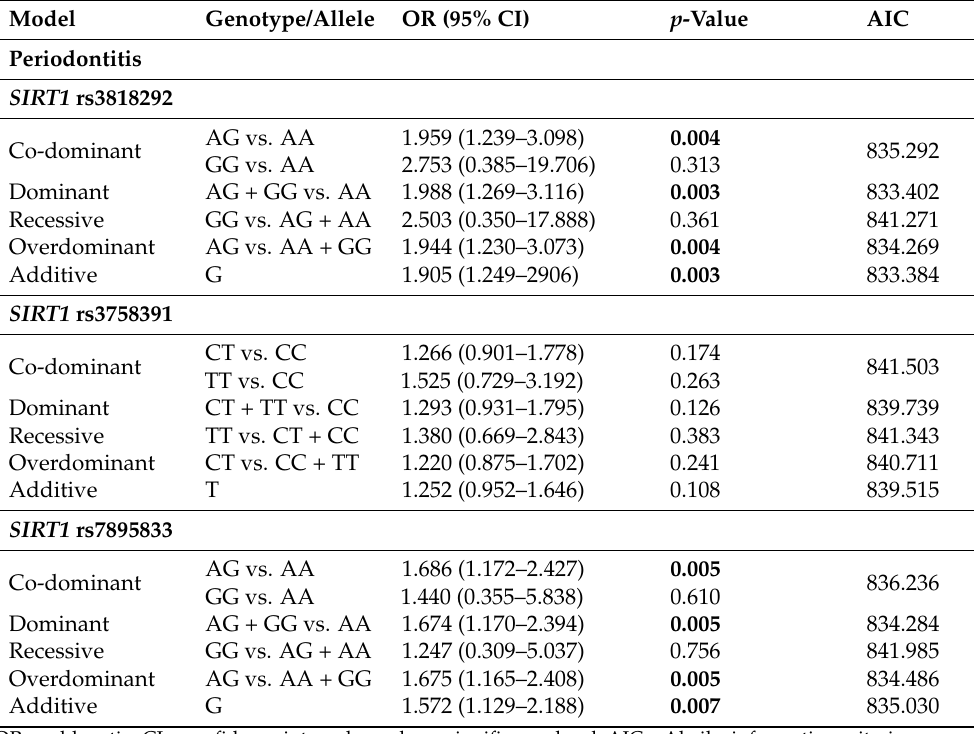
Table 3. Binomial logistic regression analysis of periodontitis and control